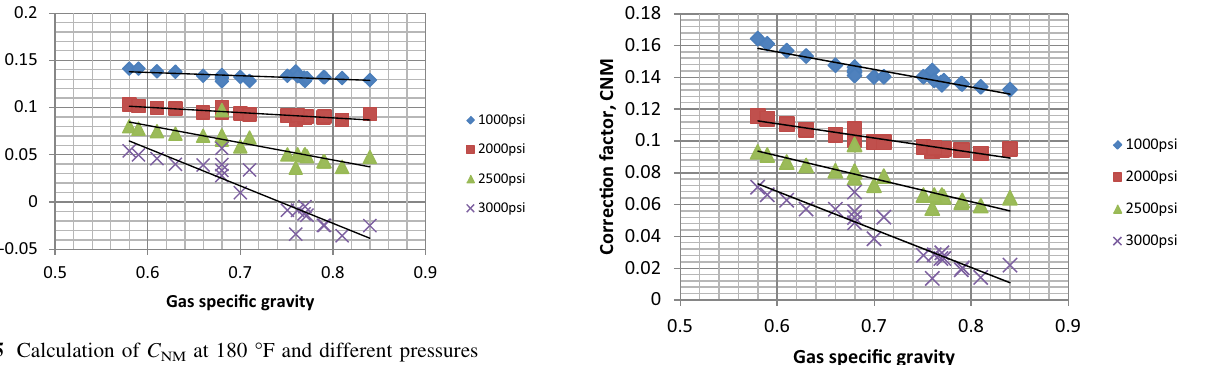
Fig. 5 Calculation of C NM at 180 (cid:3) F and different pressures